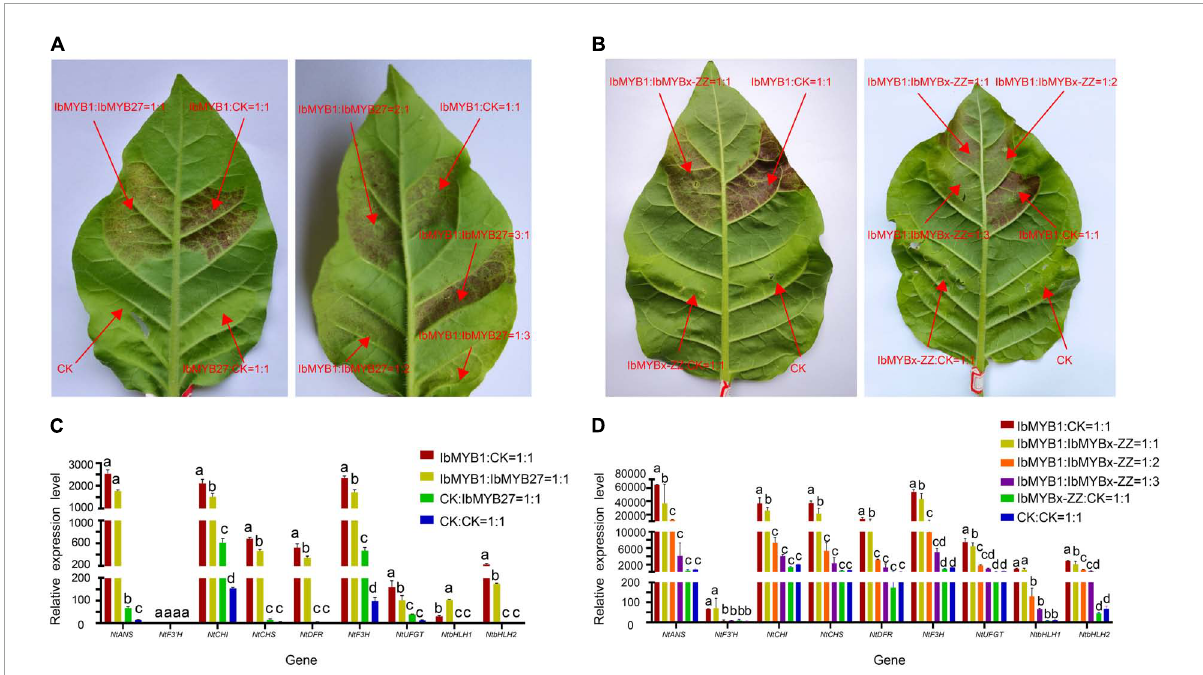
FIGURE5 Functional analysis of the sweet potato IbMYB27 and IbMYBx-ZZ TFs. (A,B) Cotransformation of IbMYB1/IbMYB27 and IbMYB1/IbMYBx-ZZ-induced anthocyanin biosynthesis, as shown by transient expression assays in tobacco leaves. Tobacco leaves